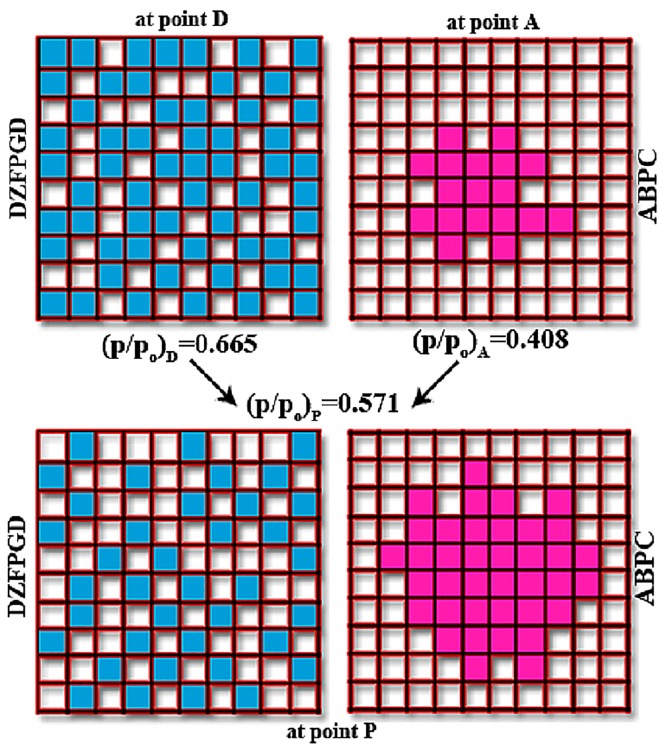
A sketch of different routes to common point P holding different distribution of equal amount adsorbed; letters and relative pressures are consistent with Fig 3.